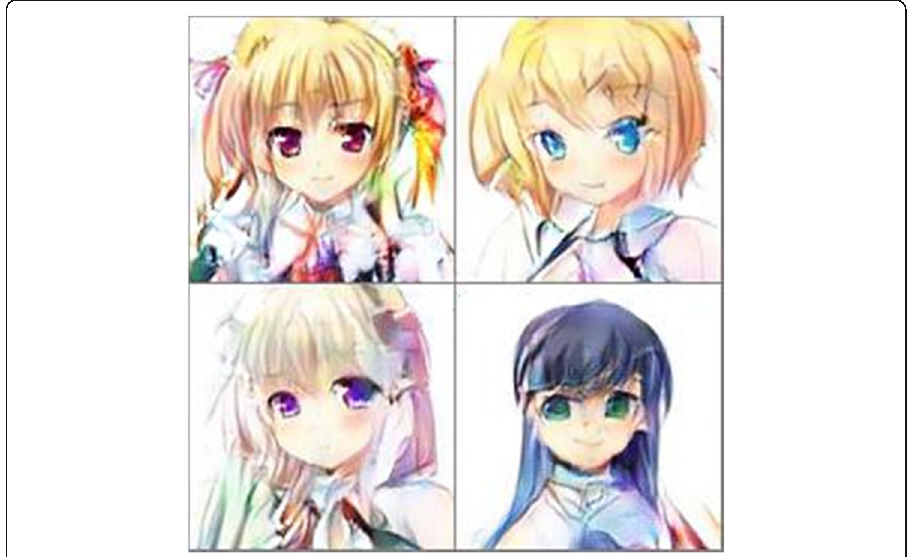
Fig. 1 An example of anime characters generated automatically by